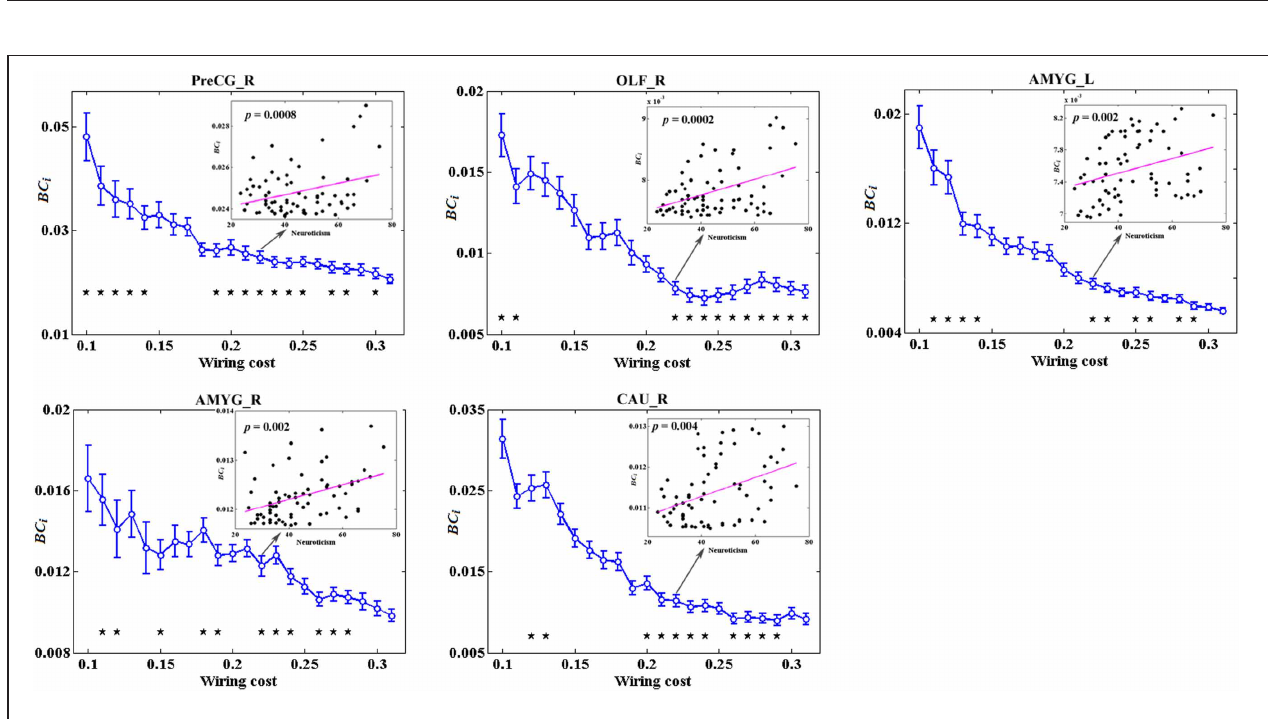
where the significant correlation between the metric and neuroticism was detected (permutation testing, p < 1 / 90). The inset figure indicates the correlation between the metric and neuroticism at wiring cost =